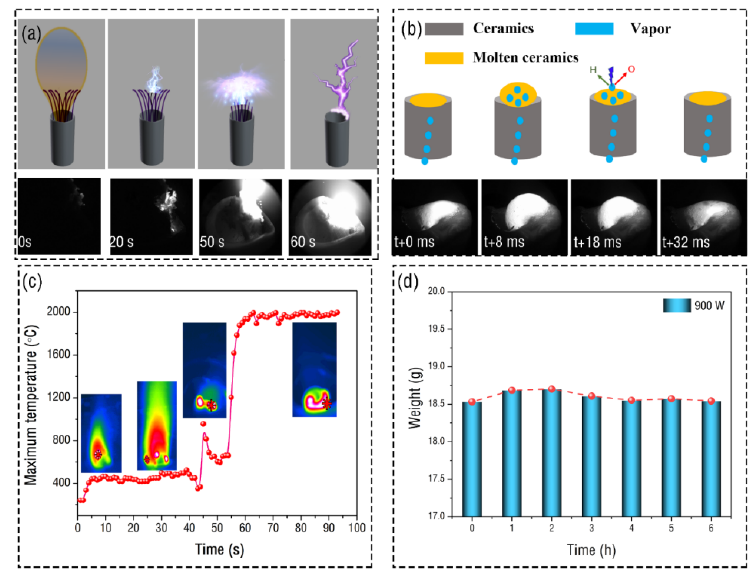
Figure 4. The excitation process of water vapor microwave plasma torch. ( a ) The wick with flame discharges under the action of the microwave, causing evaporation and discharge of water at the top of the ceramic tube (multimedia view: Video S2, the upper part is the schematic diagram). ( b ) Process of water vapor plasma excited by microwave (multimedia view: Video S3, the upper part is the schematic diagram). ( c ) Temperature changes at the beginning of the excitation of water vapor microwave plasma. ( d ) Change of mass of ceramic tube after discharge with time.